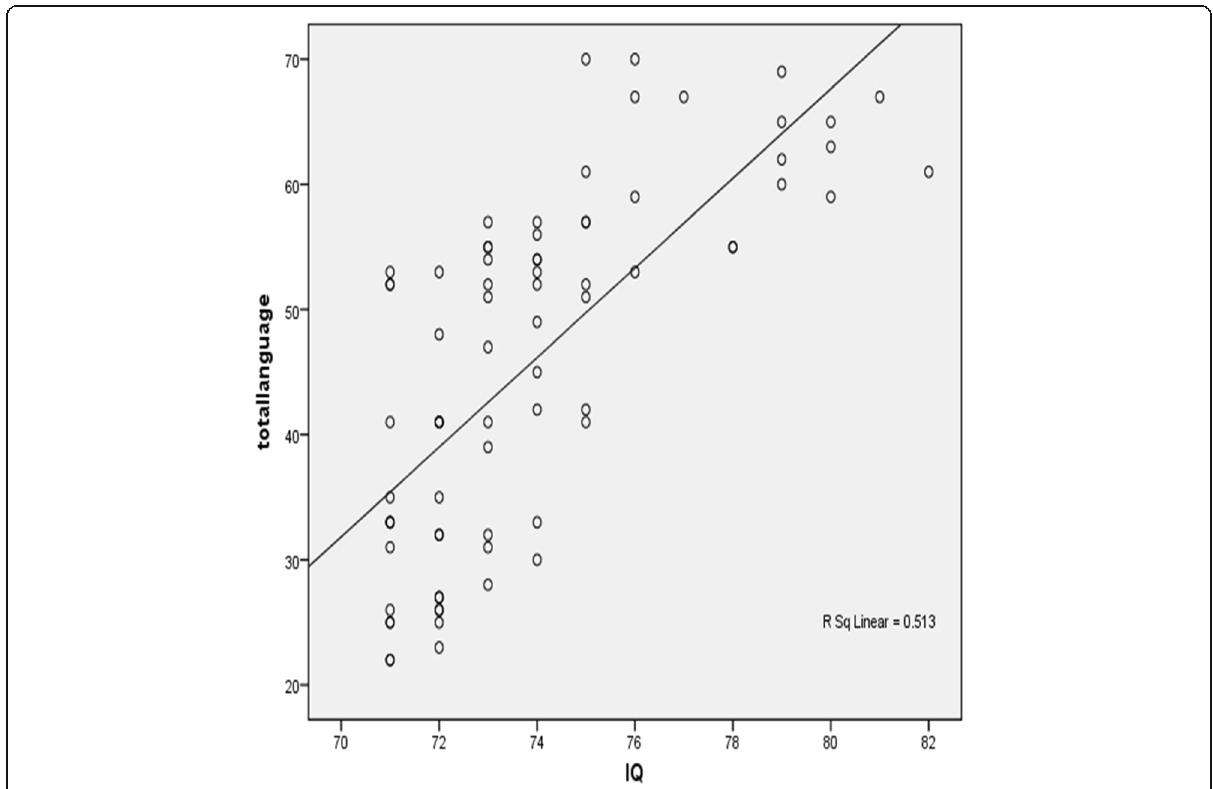
Fig. 4 Shows highly significant positive correlation between intelligence quotient (IQ) scores of all children (the three groups A, B, and C) and their total language ages ( R =